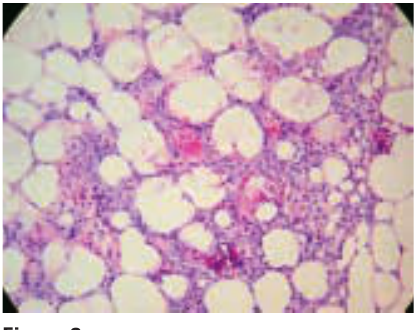
Histological slide of a biopsy nodule from the left shoulder showing patchy fat necrosis and crystallisation of fat (H&E, 40x).